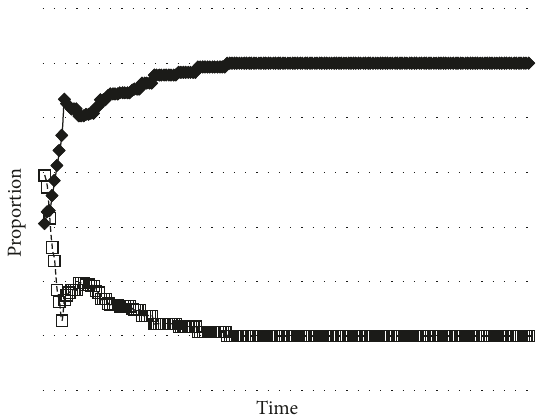
Figure9:Theevolutionarytrendoftheproducers’strategyselection in model IV.